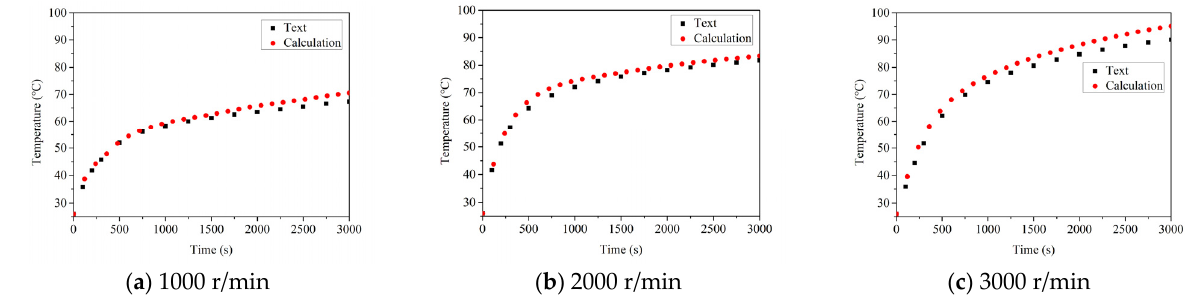
Figure 9. The influence of the speed on temperature change of damaged bearing.